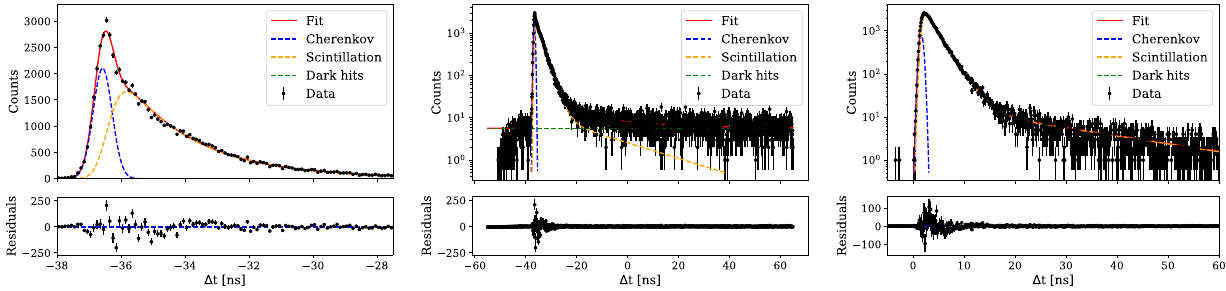
Fig. 9 The best-fit analytic model compared to the 1% WbLS data, for the peak-region of the LAPPD (left), full analysis window of the LAPPD (middle), and full analysis window of the timing PMT (right). The analytical model contains several approximations which are not present in the MC (Fig. 12, left)